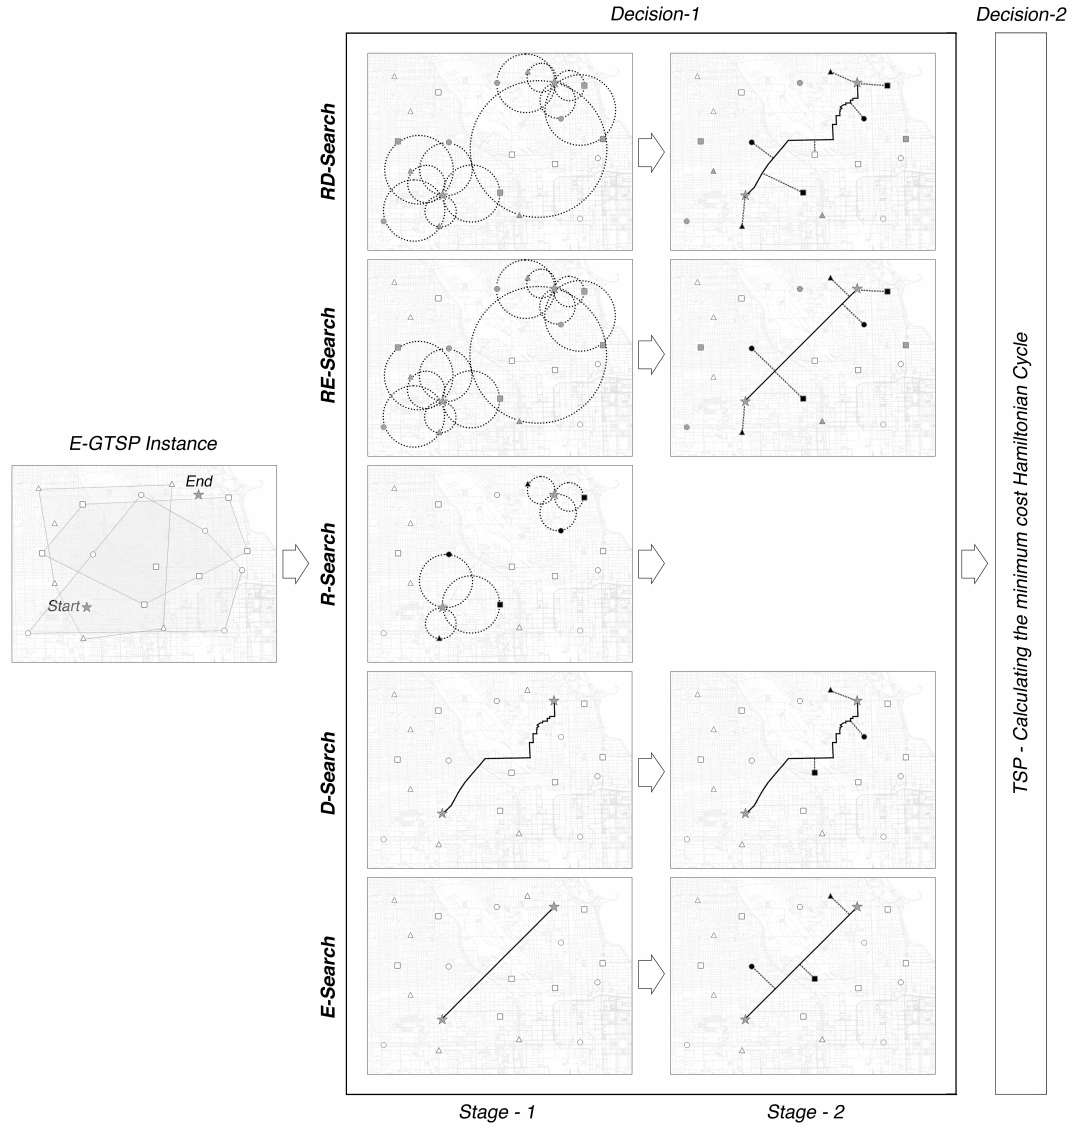
Figure 2. Diagrammatic representation of five different proposed search algorithms. Three groups of different points, marked by oval, triangular, and rectangular markers, are used to show an E-GTSP instance. It should be noted that, for R-Search, RE-Search, and RD-Search, there are two stations from each group after decision 1 (Section 2), thus generating eight (2 × 2 × 2) different TSPs for decision 2